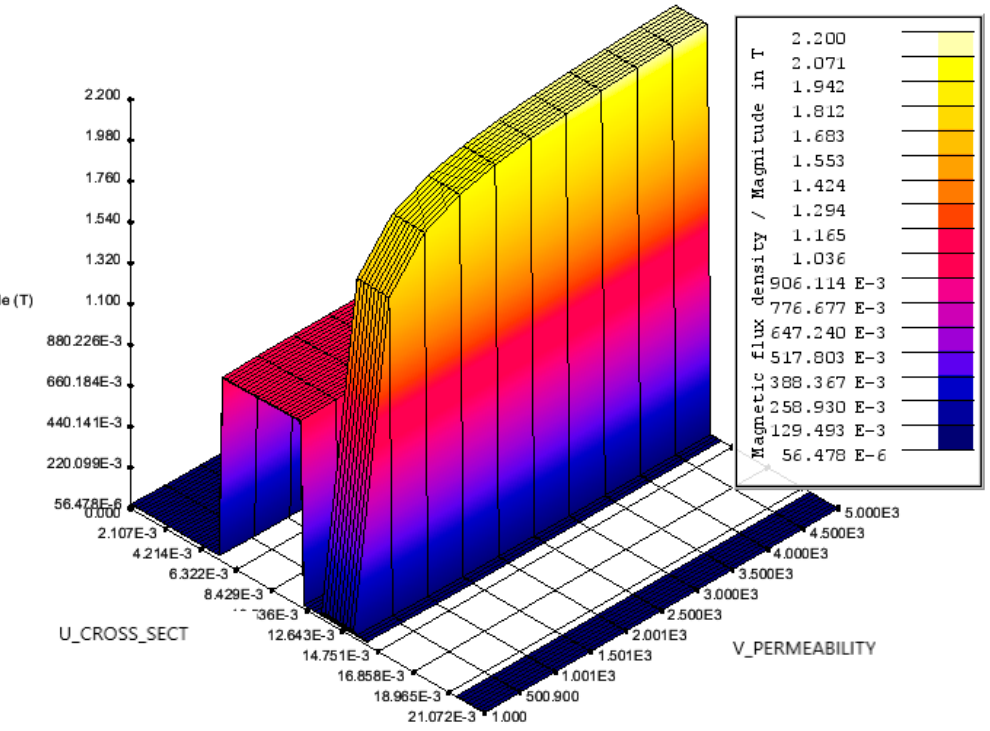
Figure 24. Variation of magnetic flux density in the cross section of the physical model.